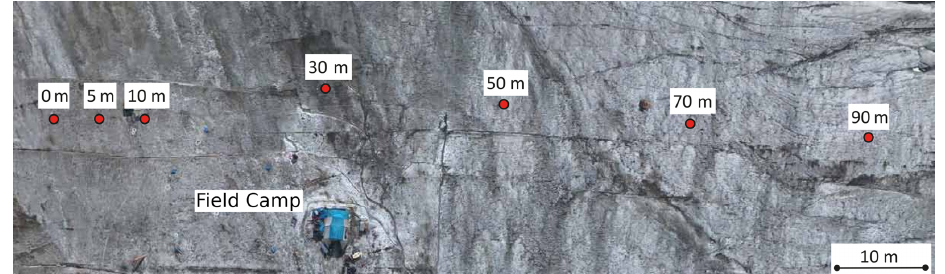
Figure 2. Aerial view of the measurement site with the location of the measurement holes. Modified photo from Markus Bobbe, TU Braun- schweig.